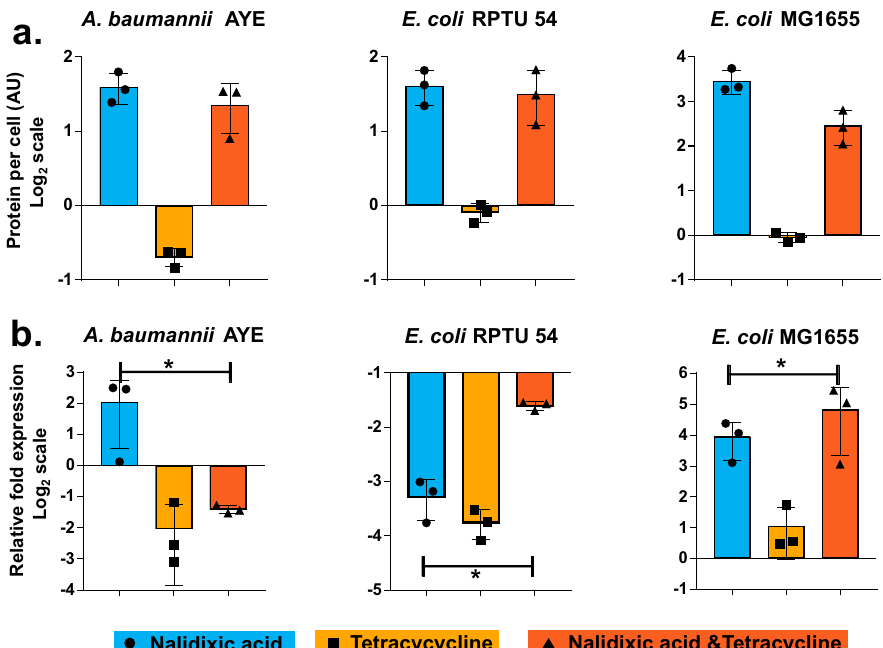
Fig. 5 Role of total protein and 16s rRNA in nalidixic acid and tetracycline combination. a Mean total protein per cell in the presence of different antibiotics. Mean total protein per cell increases in the presence of nalidixic acid but not in the presence of tetracycline. All antibiotic concentrations were used at 0.75× MIC. Data represent mean and SD from three independent experiments. All values represent ** p < 0.01; one-way ANOVA followed by the Kruskal – Wallis post test was applied. b Expression of 16s rRNA gene in the presence of various antibiotics normalized to no drug control. Relative expression of 16s rRNA gene increases in the presence of nalidixic acid but not in the presence of tetracycline. The combination of both antibiotics leads to an intermediate increase in expression. There is a remarkable difference in 16s rRNA gene expression between nalidixic acid-resistant ( A. baumannii AYE and E. coli RPTU54) and -susceptible bacteria ( E. coli MG1655). All antibiotic concentrations were used at 0.75× MIC. Data represent mean and SD from three independent experiments. All values represent ** p < 0.01; one-way ANOVA followed by the Kruskal – Wallis post test was